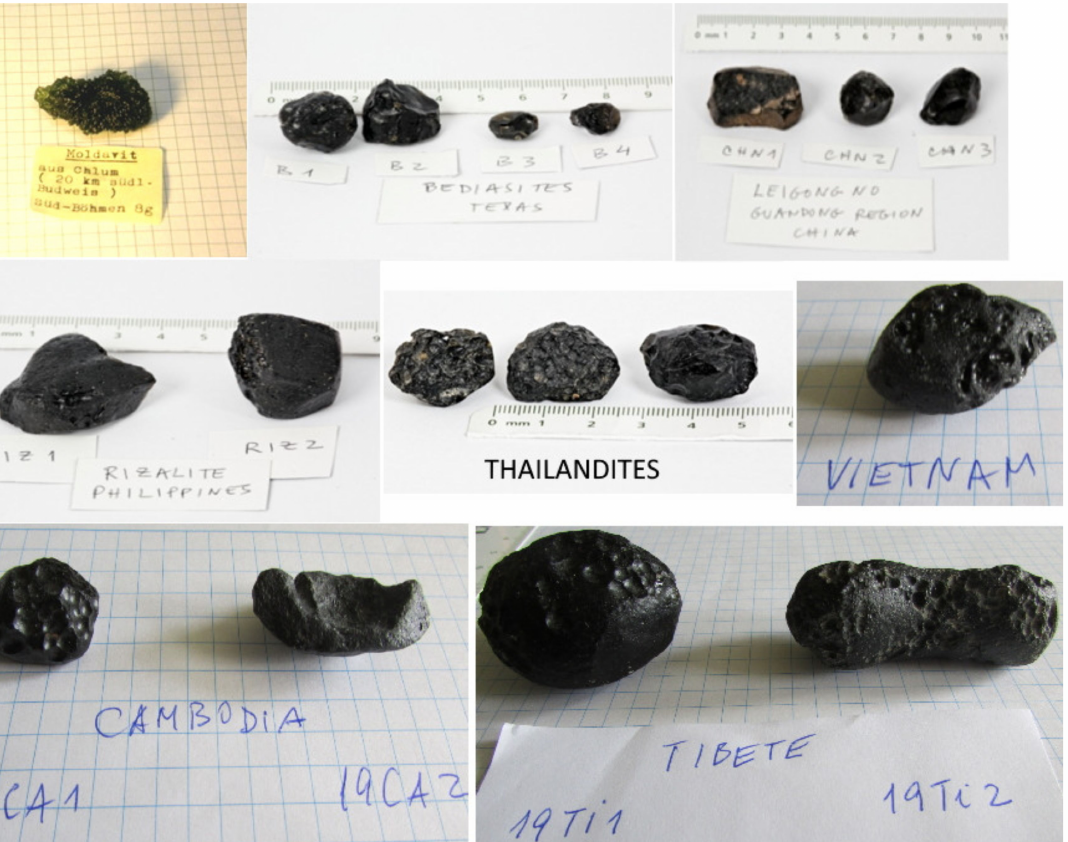
Figure 3. Examples of studied